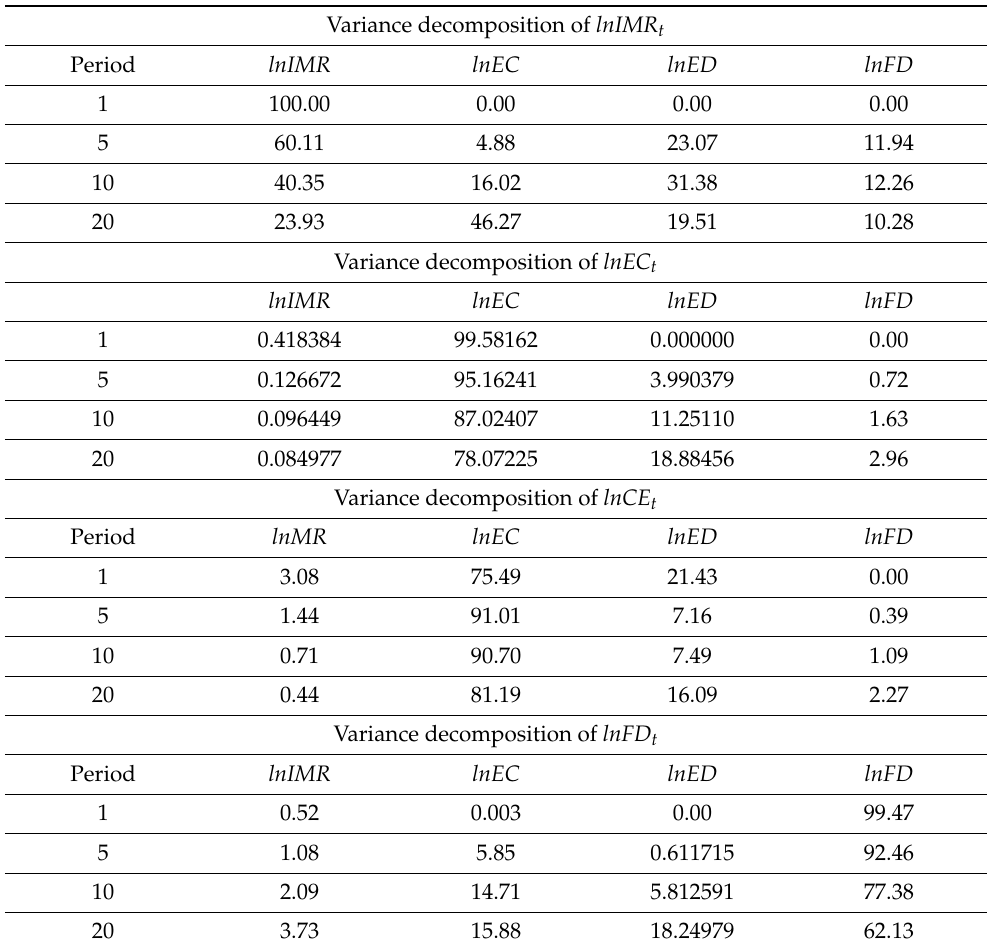
Table 11. Results of Variance Decomposition for Health Outcomes (Infant